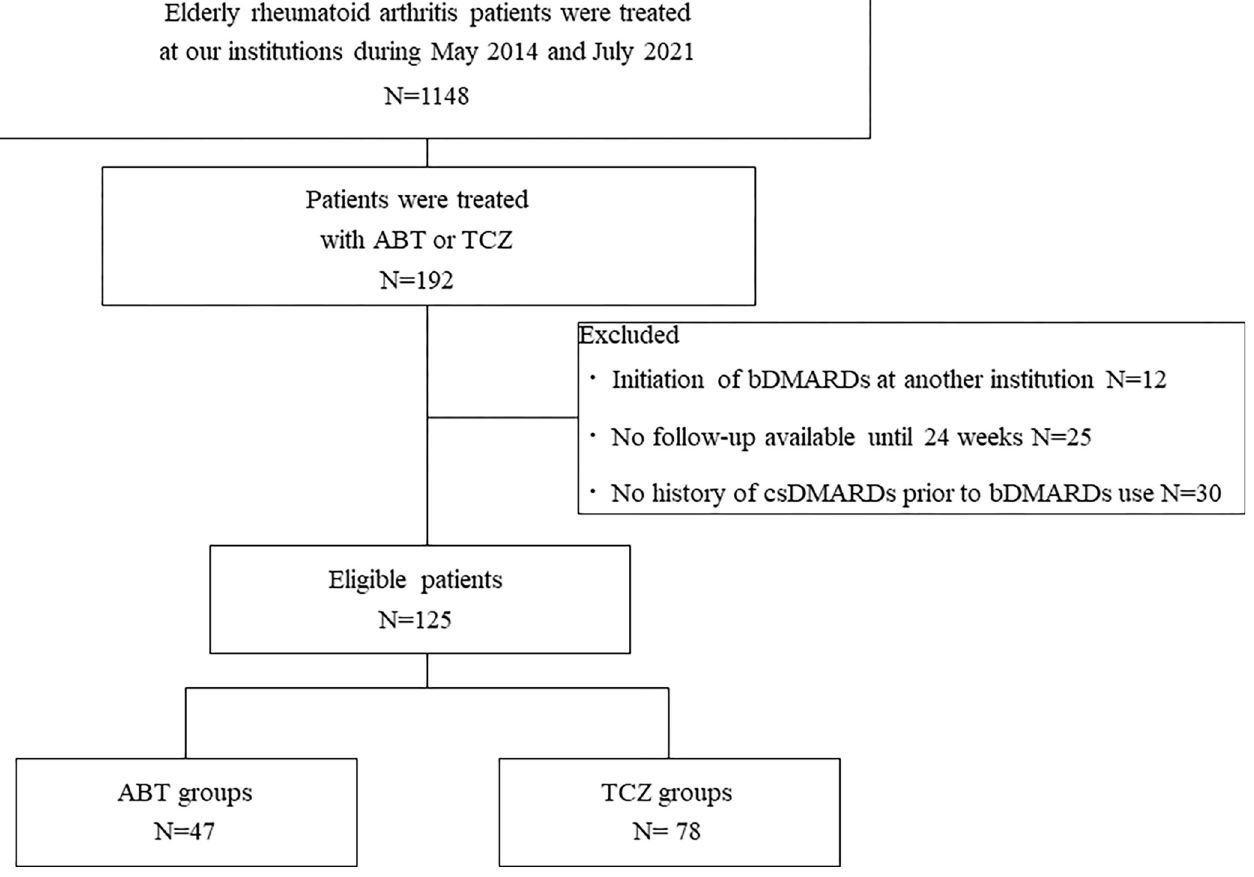
Fig 1. Flowchart of patient recruitment in our